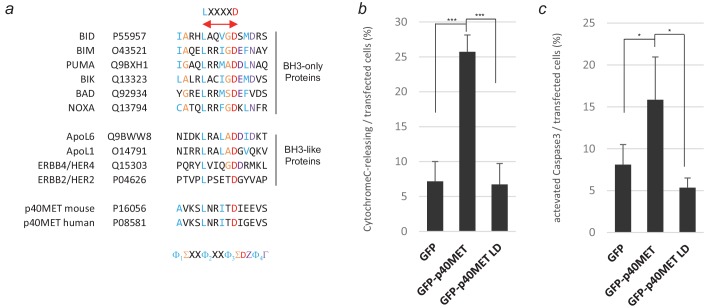
Consequence of putative BH3 domain mutation on p40MET-induced apoptosis.(a) Sequences of BH3-only proteins and BH3-like proteins were aligned with those of murine and human p40MET. The consensus sequence for the BH3 domain is shown below, with the most conserved residues highlighted in colors. (b, c) MCF10A epithelial cells were transiently transfected with a vector expressing GFP, GFP-p40MET, or GFP-p40MET LD (in which residues L1110 and D1115 were mutated). Twenty-four hours after transfection, the cells were fixed and labeled with an appropriate antibody: anti-cytochrome C (d) or anti-cleaved caspase 3 antibody (e) to evaluate apoptosis. The percentage of cytochrome C release or of caspase-3-positive cells was determined with respect to the number of GFP-positive cells. At least 100 cells were counted per well (n = 3;± S.D). *, p<0.05; ***, p<0.001 as determined by Student’s t test.Figure 2—figure supplement 5—source data 1.Source data of Figure 2—figure supplement 5b–c reporting counting of GFP, active caspase 3 and cytochrome C release positive cells, computation of the percentage, mean and SD, diagram conception and statistical analyses.